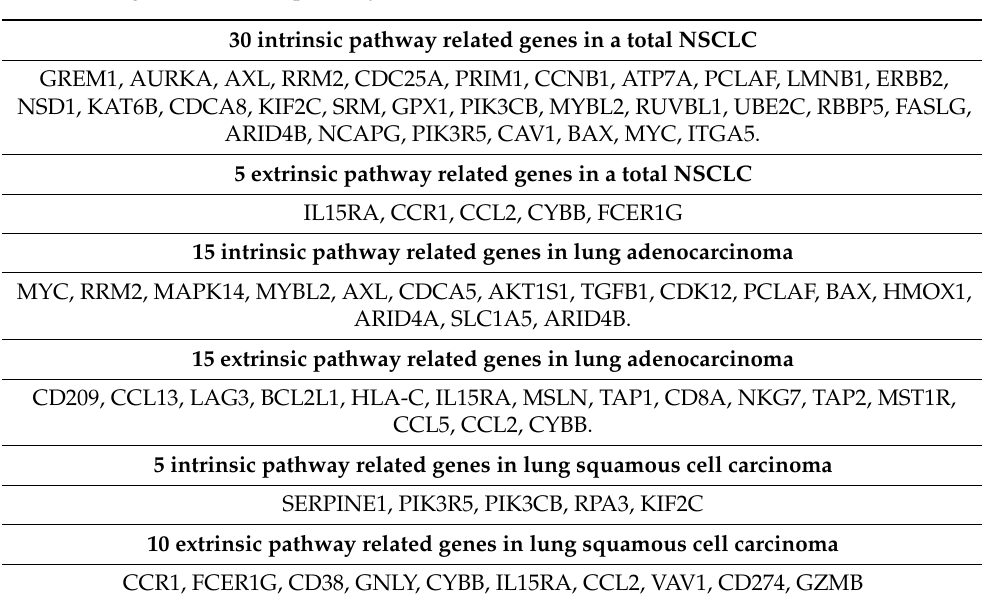
Table 1. The gene list of each